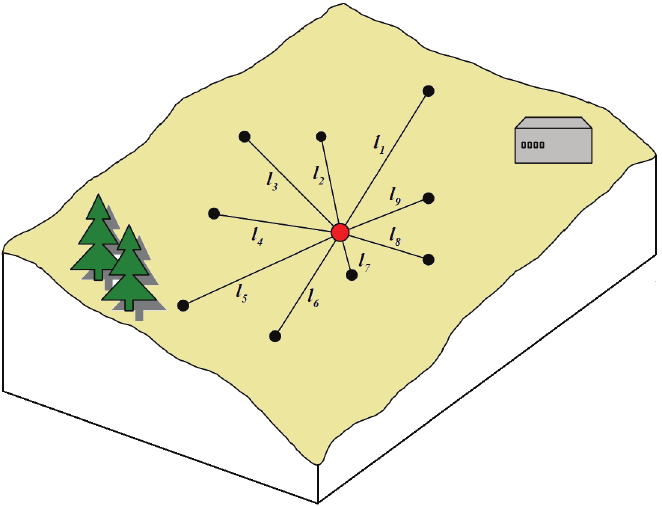
Figure 2 - Calculation of the difference squared between the paired locations.